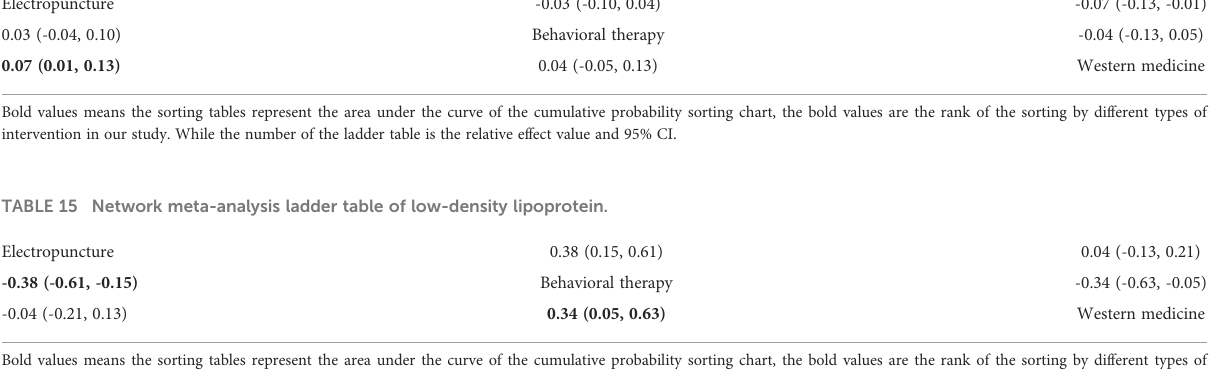
TABLE 14 Network meta-analysis ladder table of high-density lipoprotein.